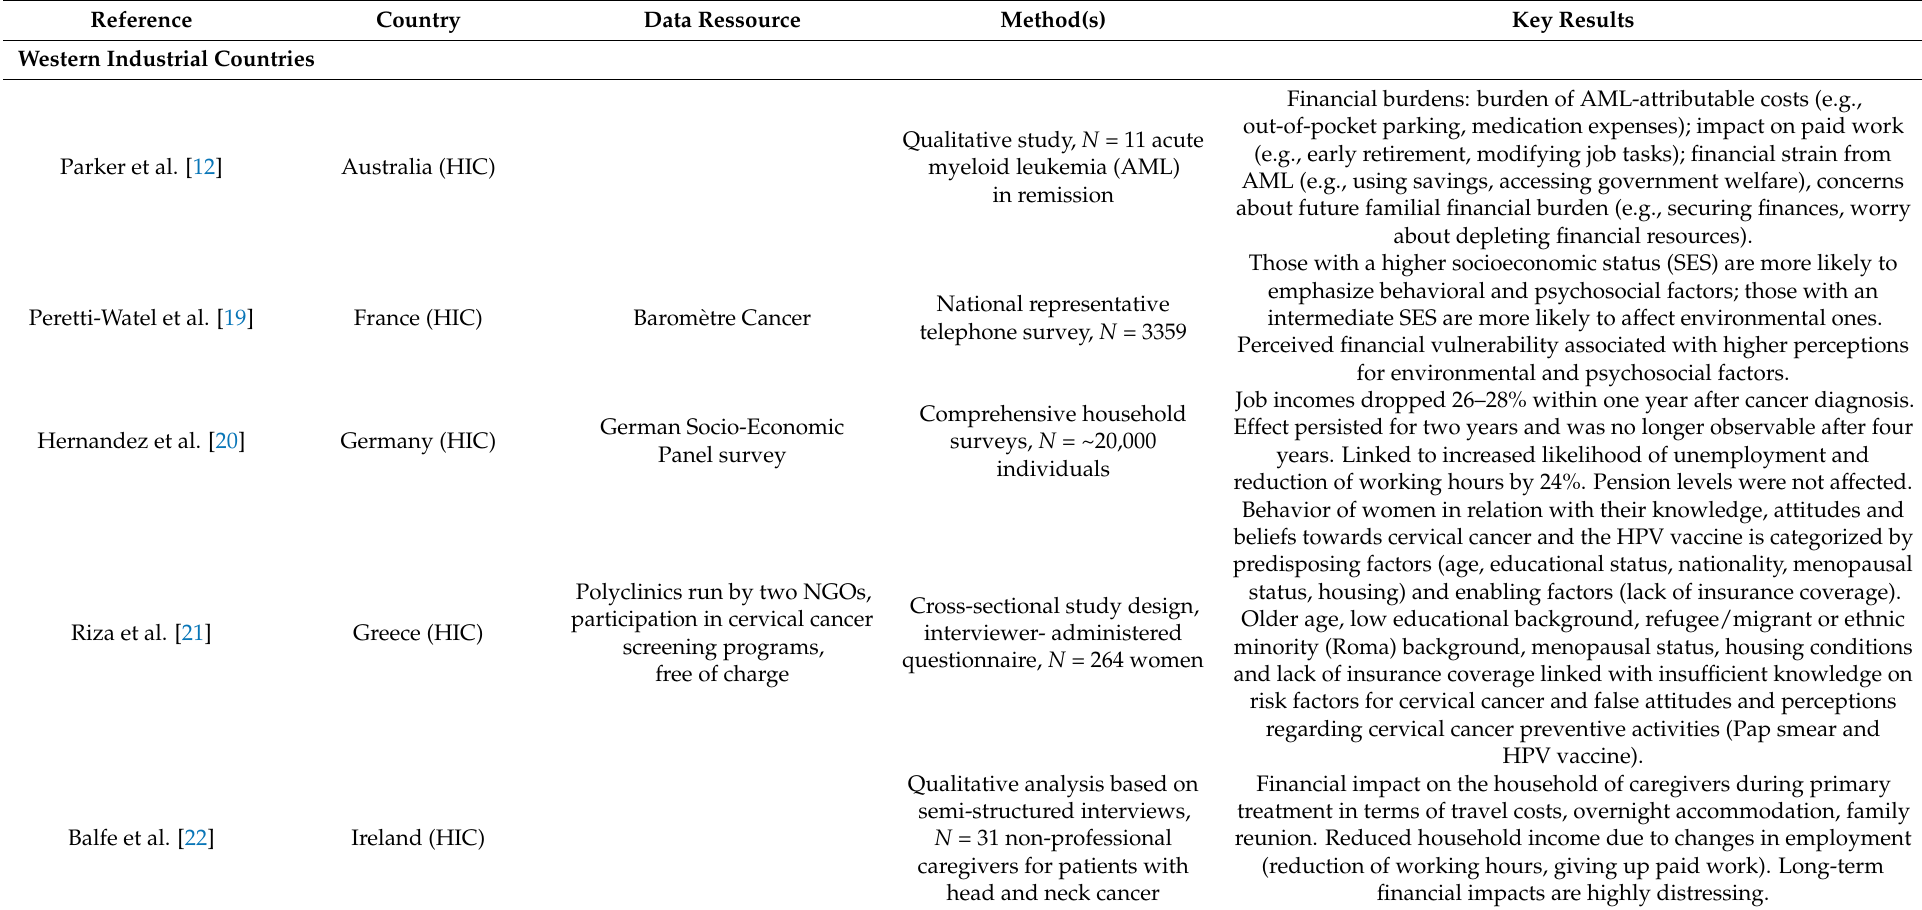
Table 1. Quantitative and qualitative research approaches of the economic burden of cancer care (sorted by country and income status). Investigations that quantified individual financial consequences are highlighted in